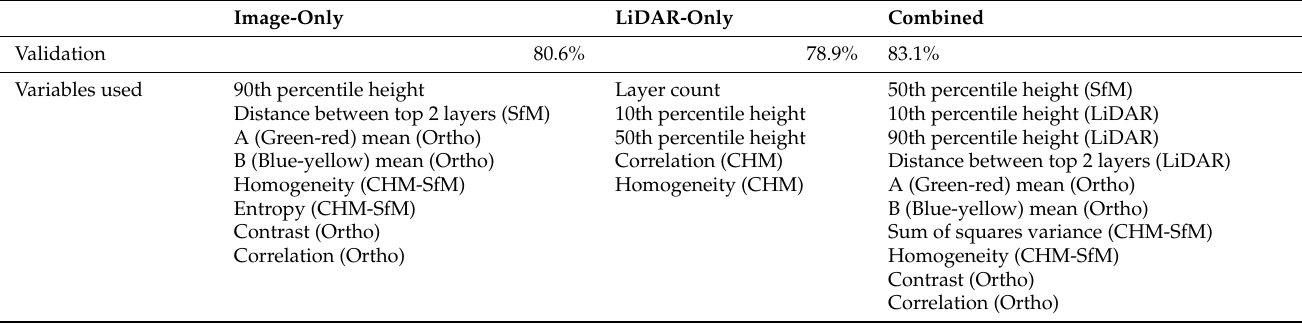
Table A1. Summary of accuracy derived from the test and validation datasets for each of the three streams of data and predictor variables used in each stream.